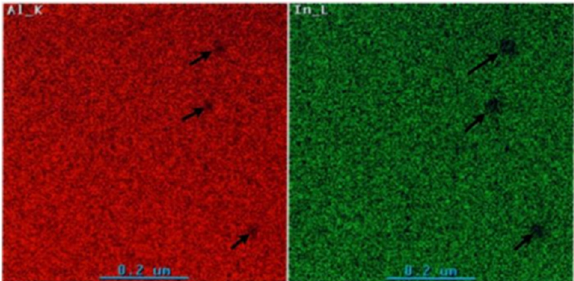
Figure 4. EDX maps of the sample E with a 450 nm-thick InAlN.